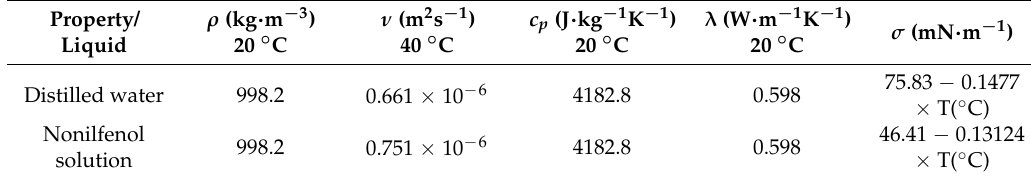
Table 2. Physical properties of the liquid phase.